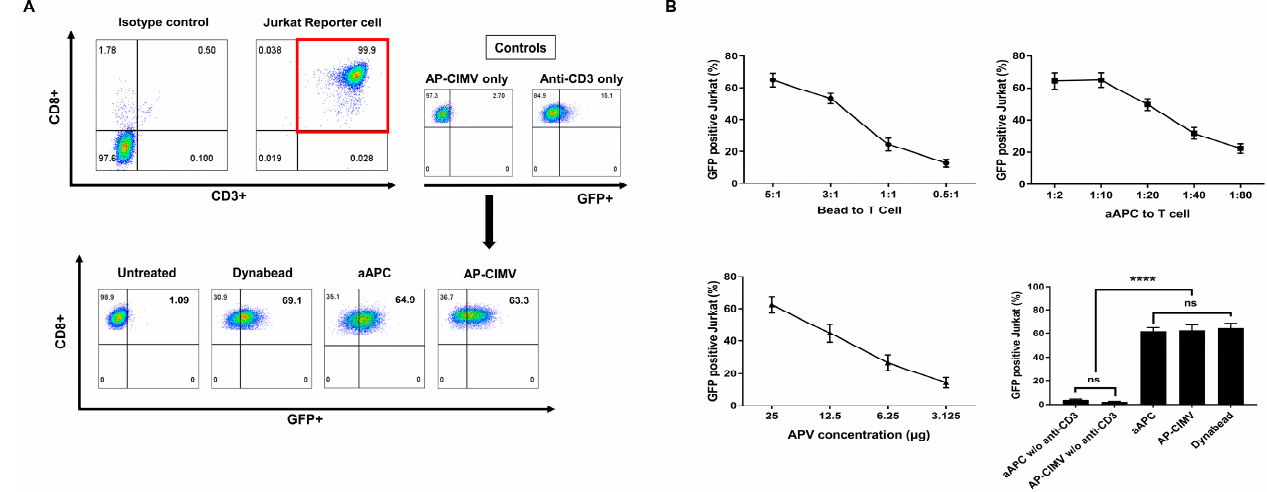
Figure 3. Activation of Jurkat reporter cells by aAPCs and AP-CIMVs coated with anti-CD3 antibody. ( A ) Induction of GFP expression in Jurkat reporter cells stimulated with aAPCs, AP-CIMVs, or Dynabead in the presence or absence of anti-CD3 antibody. Jurkat reporter cells were first gated with CD3+CD8+, and GFP expression was measured via flow cytometry. As background controls, Jurkat reporter cells cultured with AP-CIMVs alone or anti-CD3 antibody alone were measured. ( B ) Dose-dependent induction of GFP in Jurkat reporter cells stimulated with Dynabead, aAPCs, or AP-CIMVs. Representative data are shown. Every experiment was performed in triplicate and repeated at least twice. Error bars display mean values ±SD of triplicate. p value was calculated via one-way ANOVA. **** p < 0.0001.